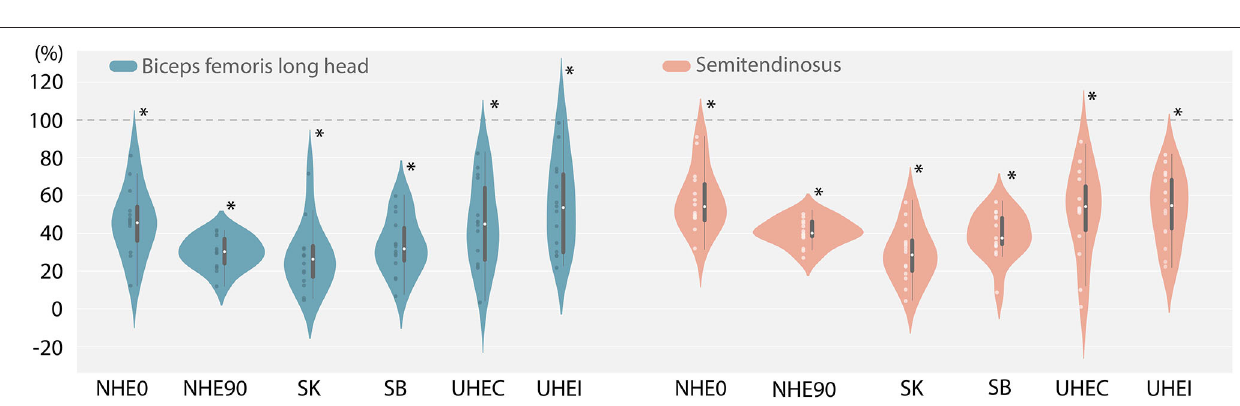
FIGURE 2 | Individual distribution, median, quartiles, minimum, maximum of biceps femoris, and semitendinosus neuromuscular activity (EMG) during exercises (%) related to the maximal burst of activity during sprint (100%). *A significant difference between this EMG activity and 100% ( p < 0.008). NHE0 and NHE90, Nordic hamstring exercise at 0 and 90 ◦ of hip flexion; UHE-I and UHE-C, Upright hip extension in isometric and concentric modalities; SK, Standing kick; SB, Slide Leg